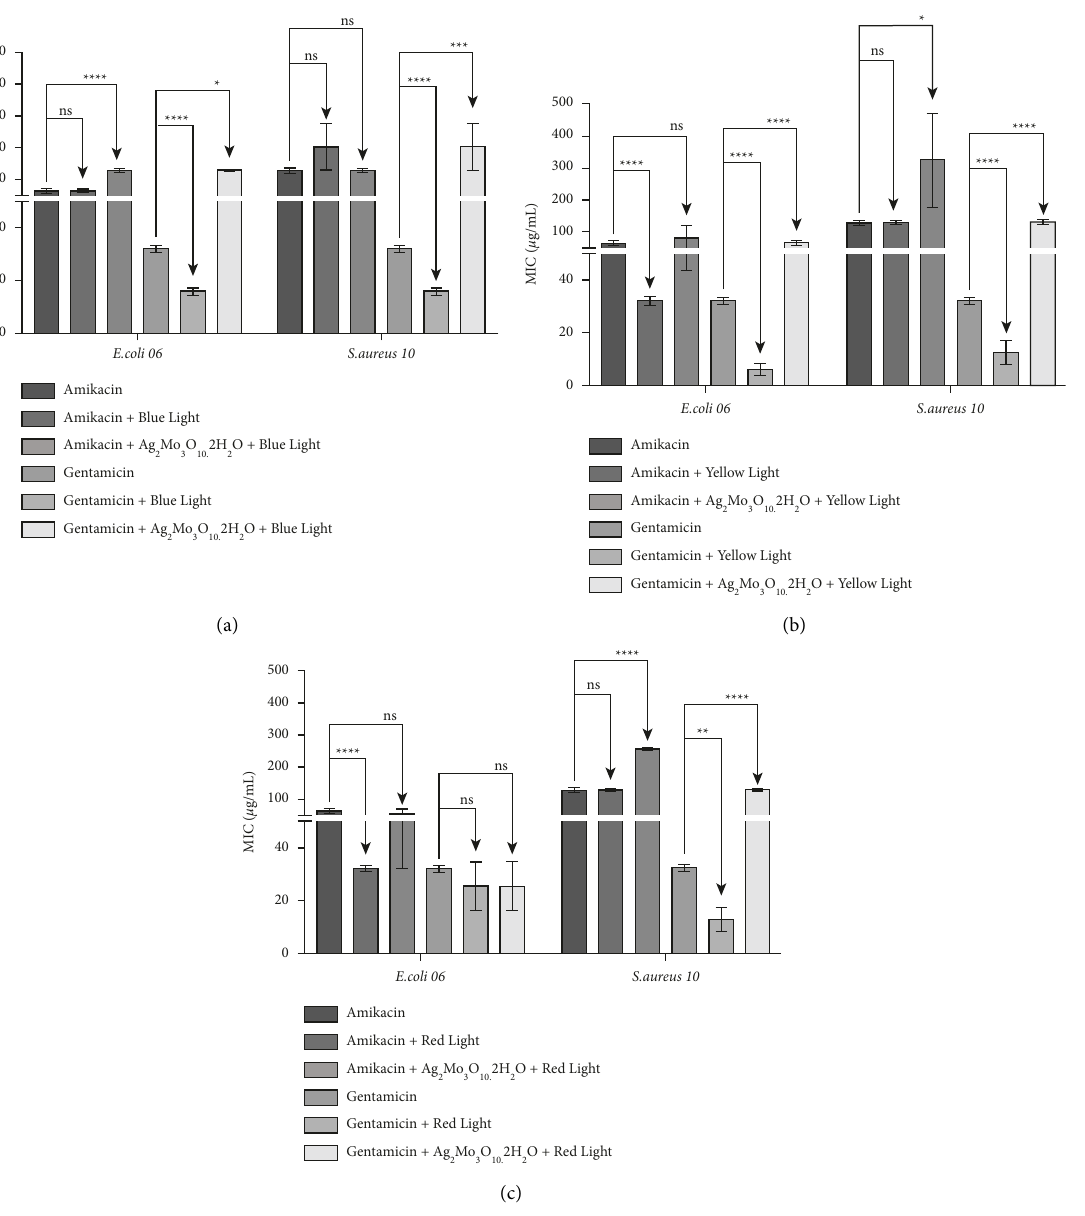
Figure 7: Minimum inhibitory concentration (MIC) of amikacin and gentamicin alone or in the presence of Ag yellow (b), or red (c) LED lights, against multidrug-resistant strains of S. aureus and E. coli . ∗∗∗∗ P < 0 . 0001 indicates significant differences between groups. Statistical significance was determined by one-way ANOVA and Bonferroni’s post hoc